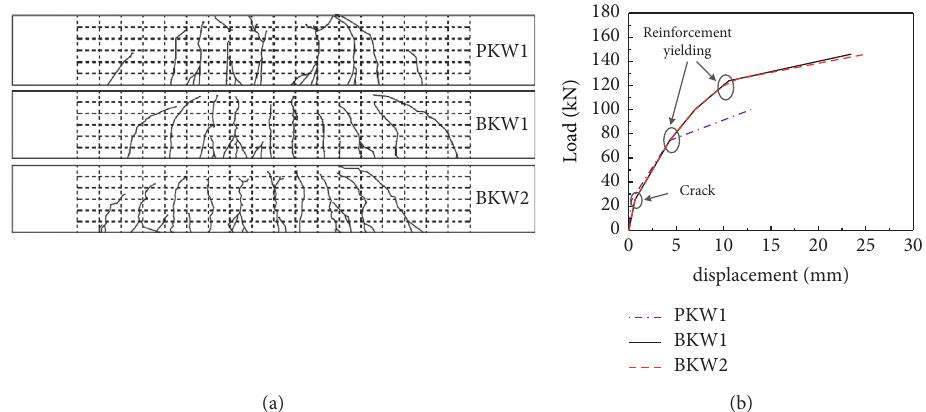
Figure 5: Comparison of the bending failure of the concrete beams reinforced with stainless steel bars and ordinary steel bars: (a) the crack distribution and (b) the load-displacement